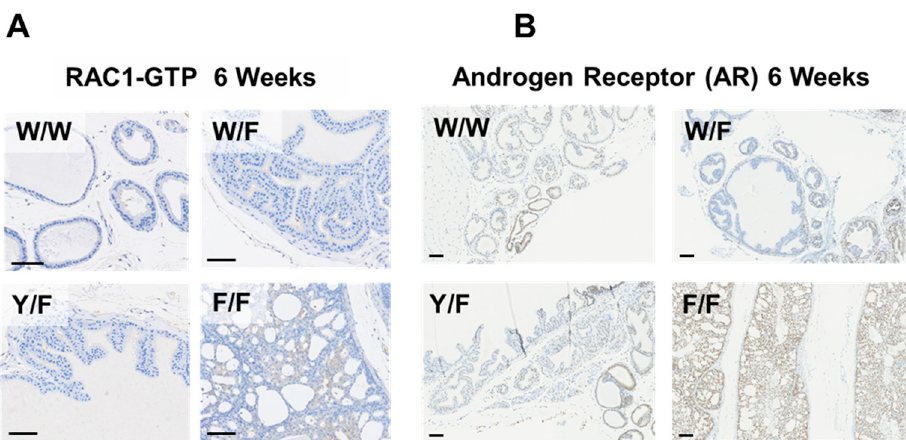
Figure 3. ( A ) Representative RAC1-GTP abundance in sections of prostate tissues from the indicated Pten mutant genotypes of mice at 6 weeks of age revealed by immunohistochemistry. ( B ) Representative immunohistochemistry for the Androgen Receptor (AR) in prostates of the indicated genotypes at 6 weeks of age. W/W = Pten + / + ; W/F = Pten + / flox ; Y/F = Pten Y138L / flox ; F/F = Pten flox / flox . Scale bars: 100 μ m. Table 1. This shows the numbers of genes found to be differentially expressed between mouse prostate samples of the indicated Pten genotype pairs. For example, 24 genes were higher in Pten +/Flox (W/F) prostates relative to Pten +/+ (W/W) prostates in samples from 6-week-old mice. Data are shown for these compared genotype pairs from animals at 6 weeks of age (top) and 20 weeks of age (bottom). The inclusion threshold was a difference in log fold change of >1.5 and p < 0.05). W/W = Pten + / +